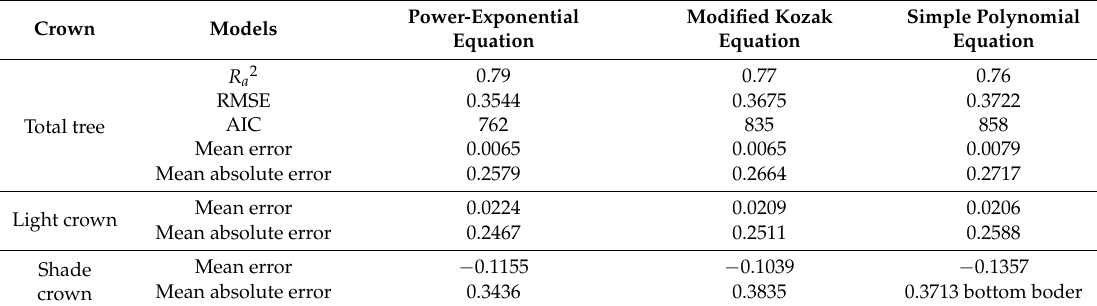
Table 3. Mean error and mean absolute error produced by power-exponential equation, modified Kozak equation and simple polynomial